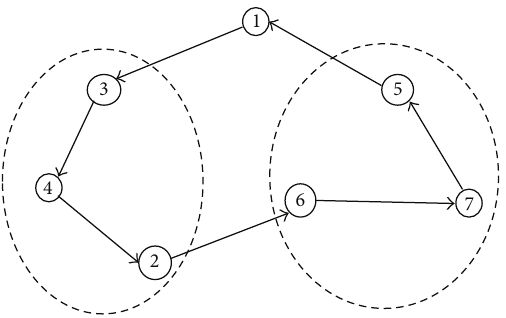
Figure 1: An example of result of the OCTSP using GA.